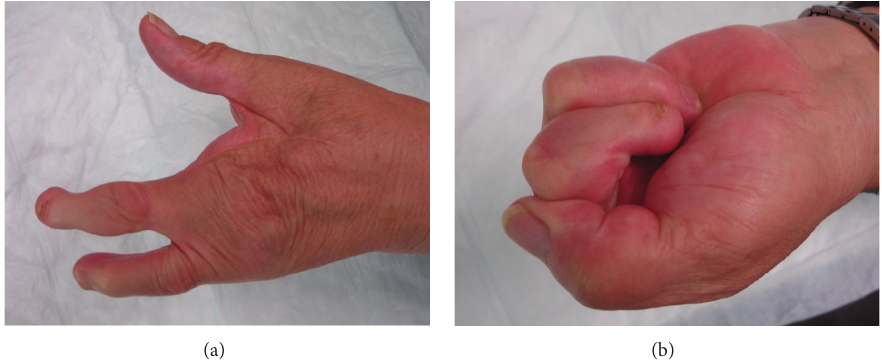
Figure 3: Postoperative result: excellent function of the